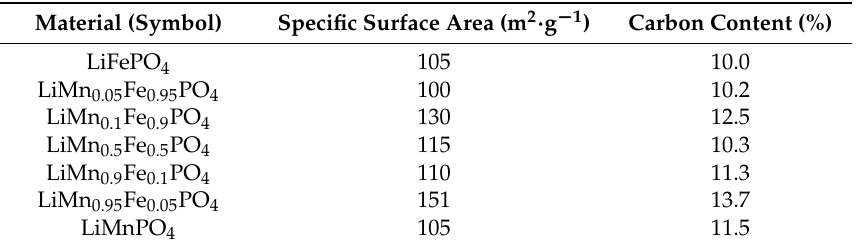
Table 4. Specific surface of cathodic powder and carbon percentage.